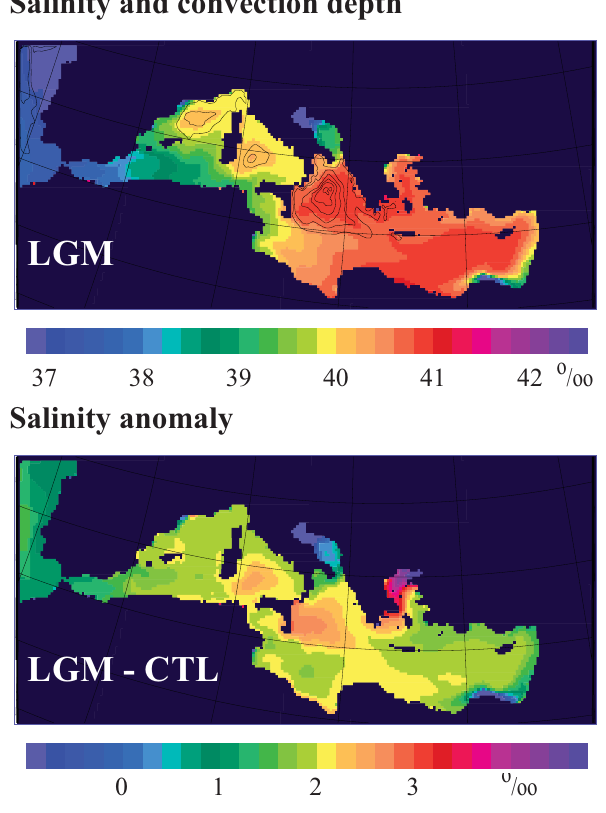
Fig. 11. Top: simulated annual mean surface salinity (colours, con- tour interval 0.2‰) and climatological maximum mixed layer depth (isolines, contour interval 250m) for LGM. For CTL see Fig. 3. Bottom: anomalies of surface salinity LGM minus CTL wth a con- tour interval of